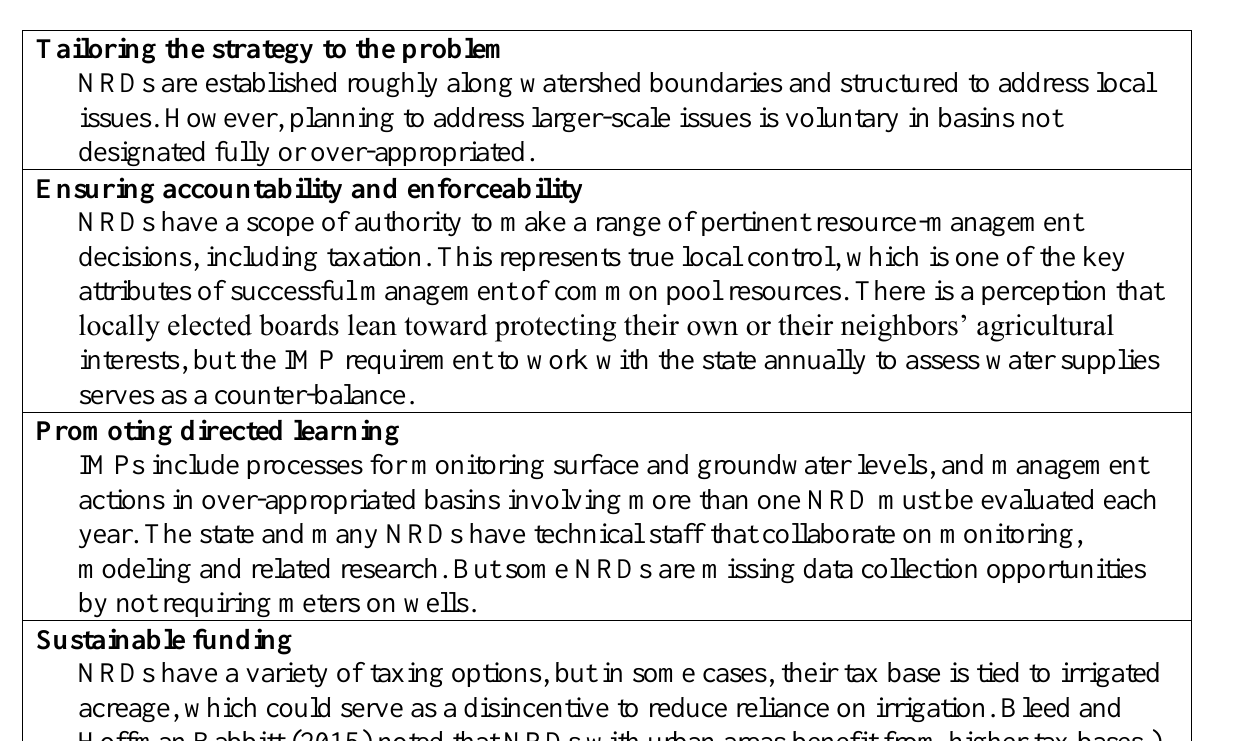
Table A2.1 Assessment of adaptive management capacity of Nebraska’s water management